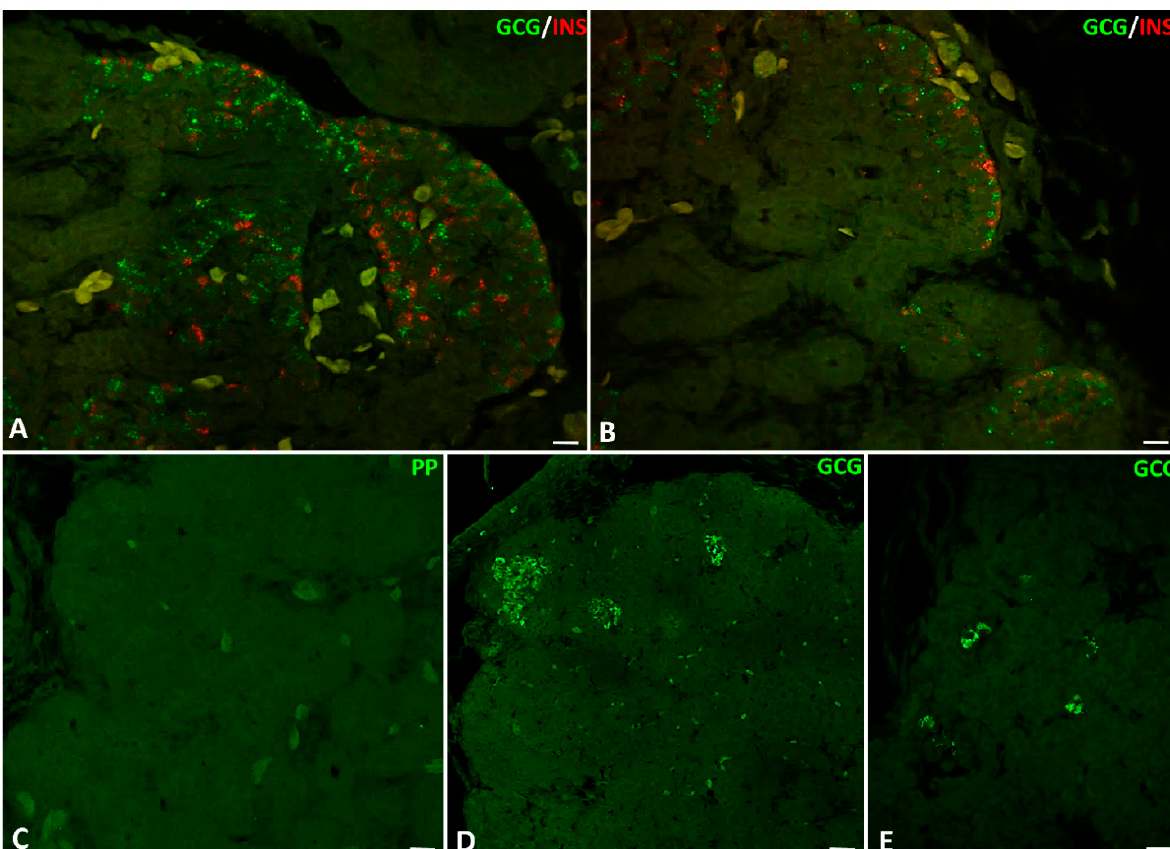
Figure 9. Arrangement of pancreatic endocrine hormone producing cells within pancreatic islets of the grass snake embryos at time of hatching. ( A , B ) Note that the A and B cells are often intermingled. ( C ) PP cells are not present within embryonic pancreas of studied species. ( D ) Large islets of A cells in more caudal part of the dorsal pancreas. ( E ) Single A cells present in the most caudal part of the dorsal pancreas. Scale bars—50 μ m.